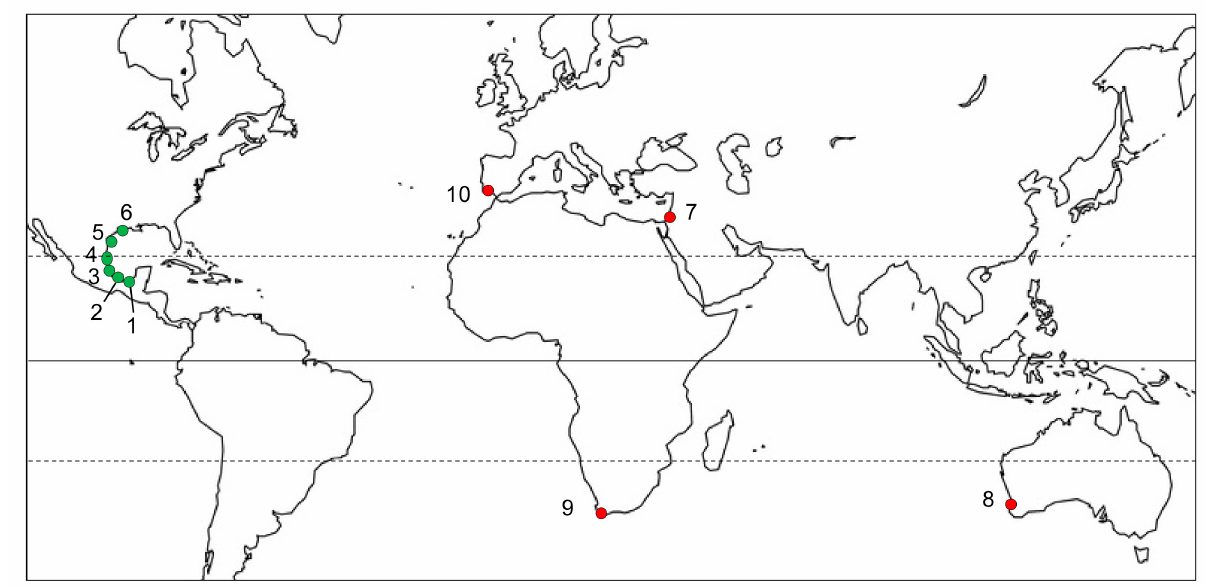
Figure 1. Geographical locations of the populations of Oenothera drummondii studied. Mexico: Native populations (green dots). Mexico: 1. Ojoshal (OJO); 2. Sontecomapan (SON); 3. La Mancha (MAN); 4. Tecolutla (TEC). US: 5. South Padre (SPA); 6. Bolivar (BOL). Non-native populations (red dots). Israel: 7. Rishon-Lezion (LEZ); Australia: 8. Mandurah (MAH). South Africa: 9. Muizenberg (MUI). Spain: 10. El Dique (DIQ). Line of Ecuador (solid black line) and intertropical region are shown (dashed black